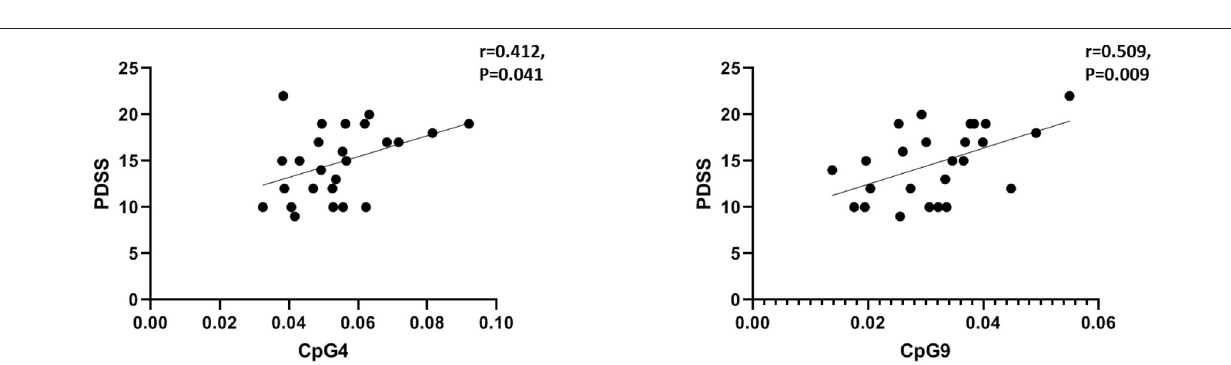
FIGURE 2 | Correlations between the clinical symptoms (PDSS scores) and CpG4 and CpG9 DNA methylation in the panic disorder (PD) group. The threshold was set at a significance level of p < 0.05. PDSS , Panic Disorder Severity